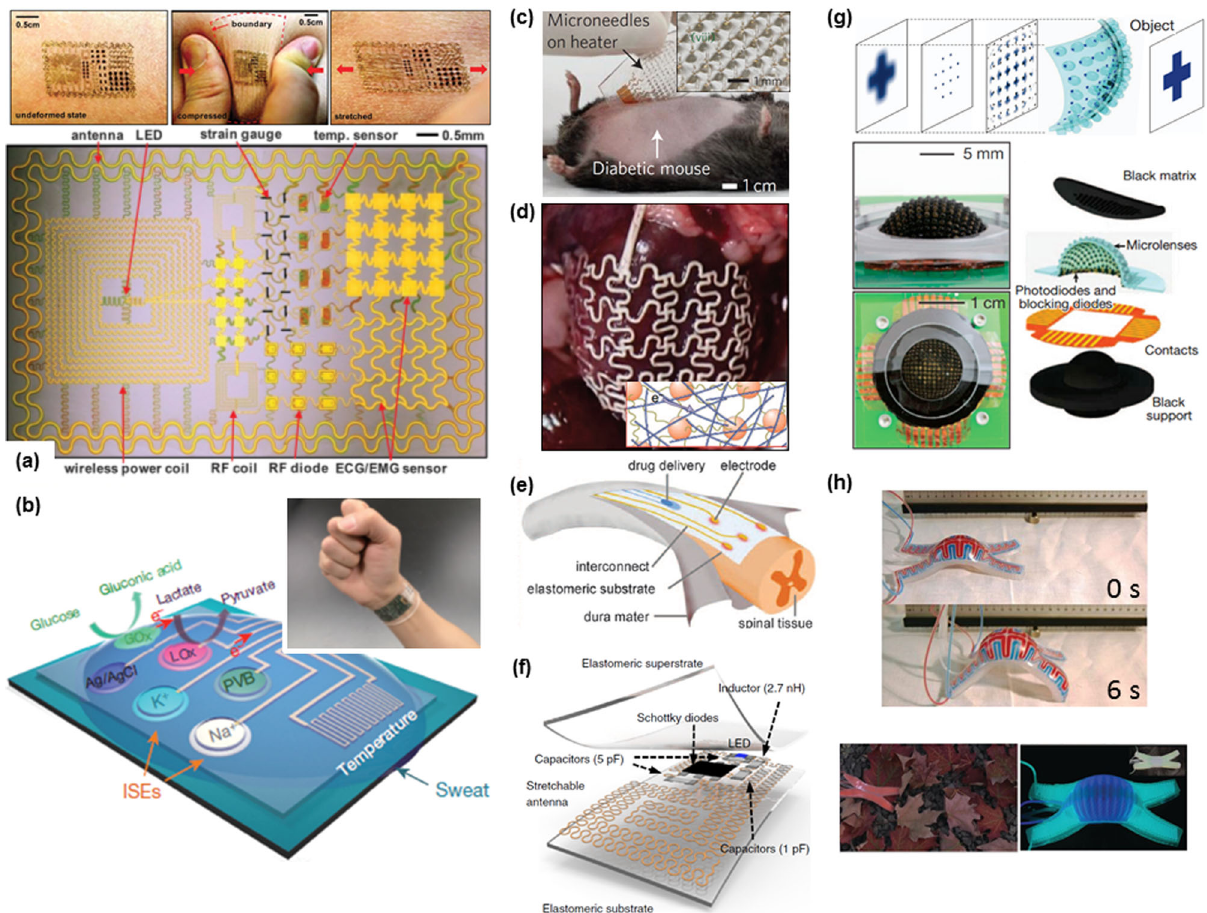
Fig. 8 Integrated systems. a Integrating multiple functional components that include sensors, LEDs, wireless data/power modules in a single epidermal platform enables such electronics to continuously transmit the monitored physiological signals to the external circuits. Reprinted with permission from ref. 90. b Fully integrated wearable sensor array for real-time perspiration analysis, including metabolites (e.g., glucose and lactate) and electrolytes (e.g., sodium and potassium ions). Reprinted with permission from ref. 91. c Optical image of the gold-doped graphene heater integrated with the drug-loaded microneedles (inset) on the skin near the abdomen of the mouse with hair shaved off. The dissolution of a thermally active bioresorbable coating layer on microneedles triggers transdermal delivery of Metformin to reduce blood glucose levels. Reprinted with permission from ref. 92. d Photograph of the epicardial mesh implanted on heart, where the mesh was fabricated by dispersing conductive Ag nanowires (AgNW) homogeneously in the organic-phase styrene-butadiene-styrene (SBS) rubber network. Inset shows stretched elasto-conductive mesh (ball: hard domain in SBS, wavy yellow line: elastic domain in SBS, straight blue line: conductive nanowire with polyvinylpyrrolidone ligand of AgNW partially exchanged to hexylamine using NOBF 4 ). Reprinted with permission from ref. 93. e Schematic illustration of the electronic dura mater inserted in the spinal subdural space of rats for electrical excitation transmission and local drugs delivery. Reprinted with permission from ref. 95. f Exploded view schematic of the optoelectronic system with an integrated LED and an energy harvester component to wirelessly modulate neuronal activity. Reprinted with permission from ref. 96. g Arthropod-inspired cameras on hemispherical shapes with a wide-angle fi eld of view, low aberrations, high acuity to motion, and an in fi nite depth of fi eld. Exploded view illustrates the components of this system: perforated sheet of black silicone (black matrix), hemispherical array of microlenses and photodiodes/blocking diodes, thin fi lm contacts for external interconnects, and hemispherical supporting substrate of black silicone. Reprinted with permission from ref. 97. h A soft quadruped moves through actuation from micro fl uidic channels (left, major ruler division of 1 cm). The micro fl uidic network also enables camou fl age (upper right) and display coloration (lower right, glowing in the dark using chemiluminescence; inset, the same robot photographed in the light). Reprinted with permission from ref.